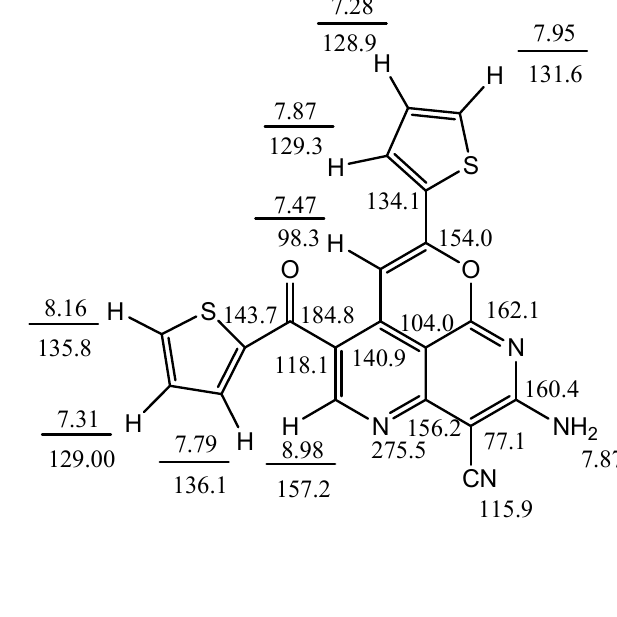
Figure 5. Left part: ( 13 C, 1 H) couplings n J (n = 2–4) according to the crosspeaks observed in HMBC measurement of 20a . Right part: Assignment of all 1 H and 13 C signals and one 15 N signal of 20a . The  values obtained in CD SOCD at room temperature are related to 3 3 (liquid). The measurements were performed at 14.1 T (600 MHz for 1 TMS and NH 3